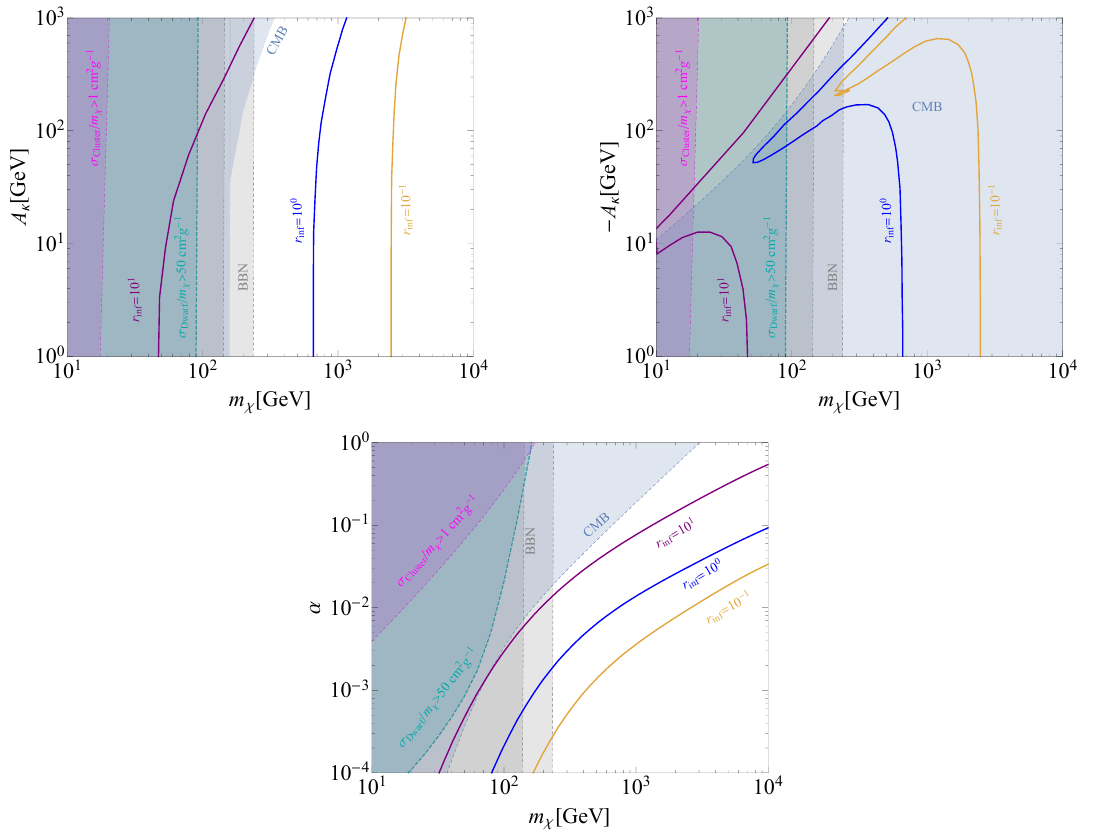
Figure 5 . Constraints on the parameter space. The solid lines satisfy relic density of Ω h 2 = 0 . 11 for different r . The Green and magenta-shaded regions are constrained from dwarf and cluster inf scale SIDM cross-sections. The gray shaded regions indicates where mediator decays occur after neutrino decoupling and is excluded by BBN. The light blue shaded regions are ruled out by CMB constraints. The α and A are fixed to 0 . 01 and 100 GeV on the top and bottom panels, respectively. κ The mass ratio is m = 10 − 5 φ /m χ